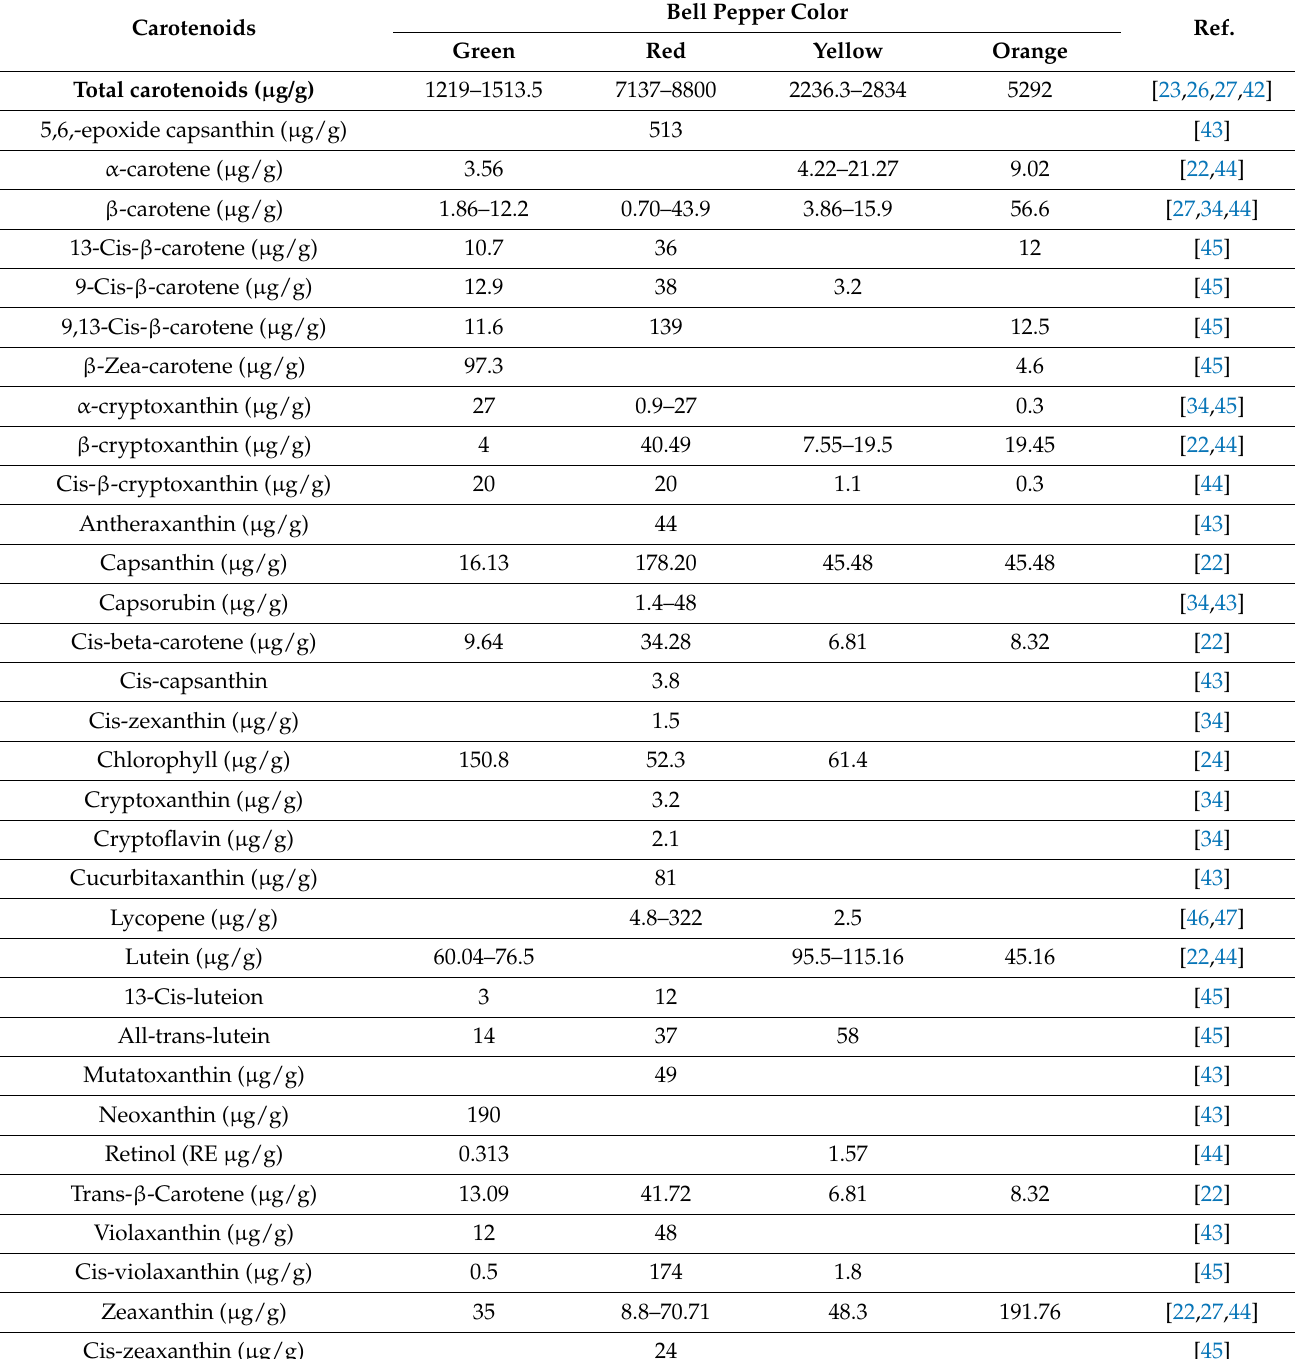
Table 3. Carotenoids content in bell pepper